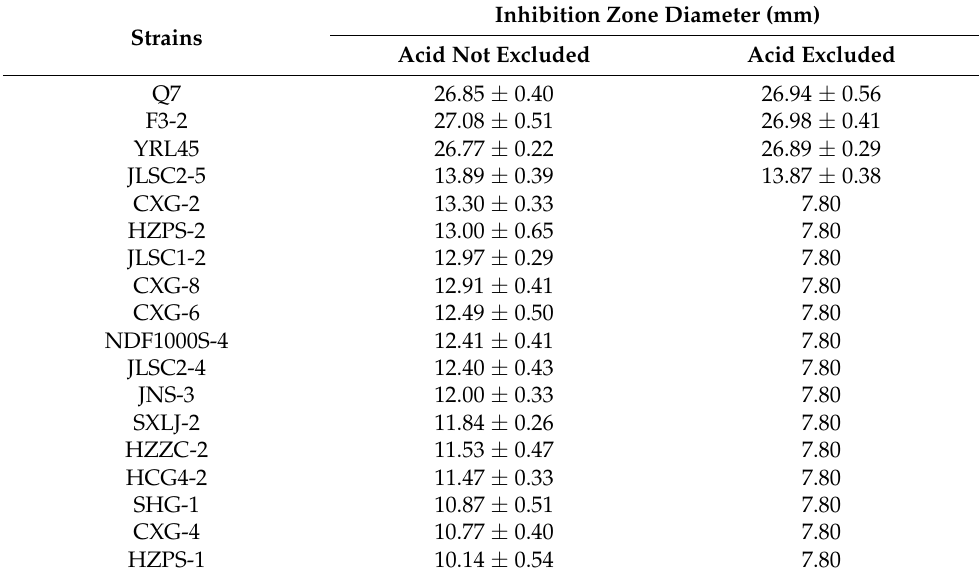
Table 2. Screening of L. plantarum with antibacterial activity.